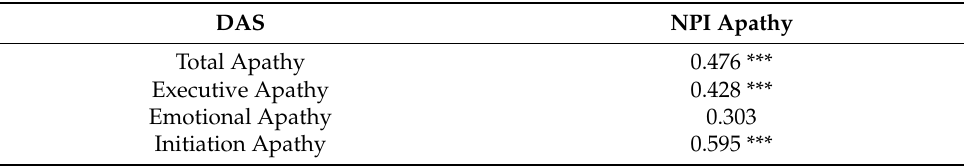
Table 9. Correlations between DAS apathy & NPI apathy in ADD